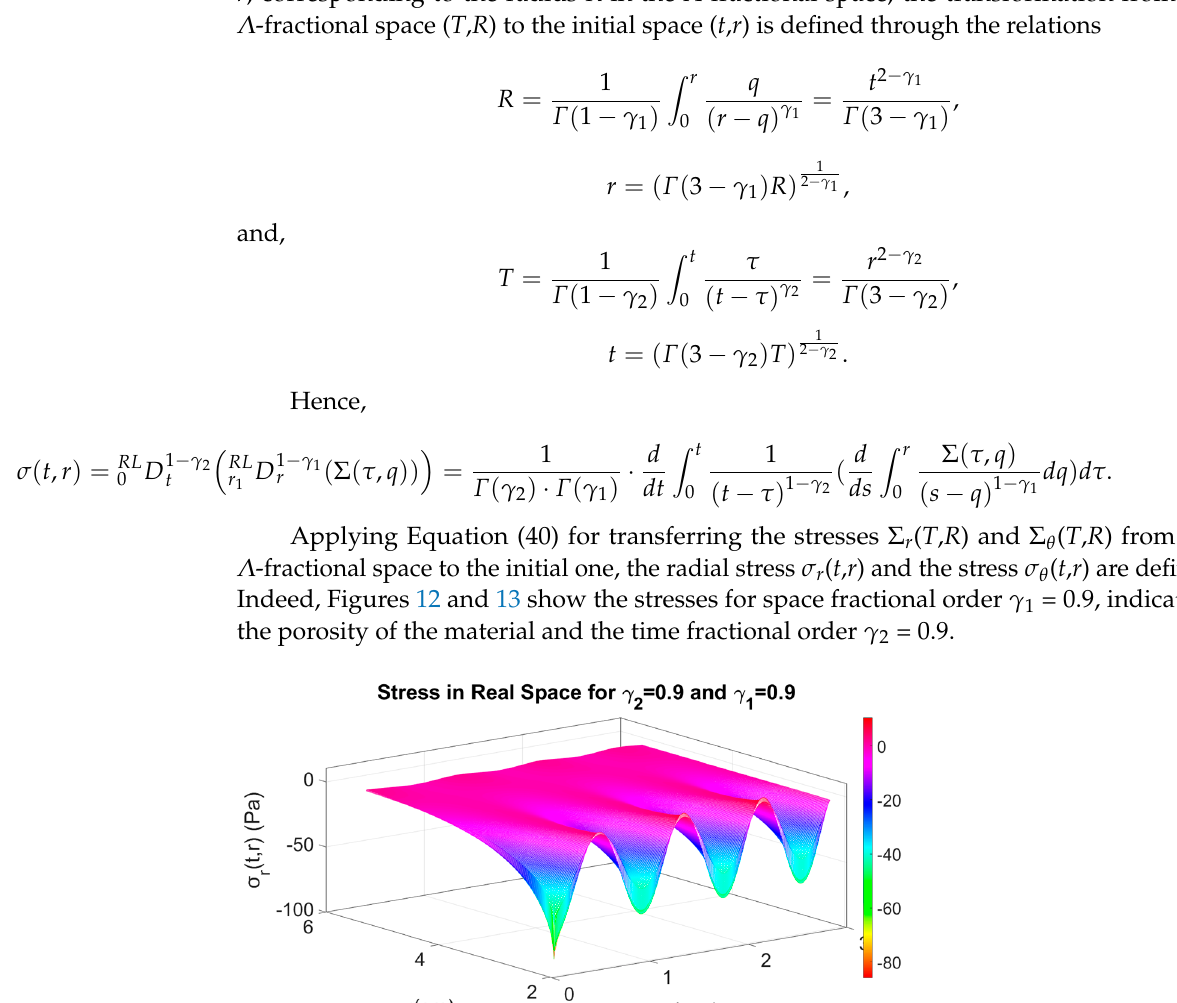
Figure 14. Distribution of the radial stress 𝜎 (cid:3045) (𝑡, 𝑟) in the initial space with space (porosity) fractional order γ 1 = 0.7 and time fractional order γ 2 = 0.9. Figure 15. Distribution of the stress 𝜎 (cid:3087) (𝑡,𝑟) in the initial space with space (porosity) fractional order γ 1 = 0.7 and time fractional order γ 2 = 0.9.